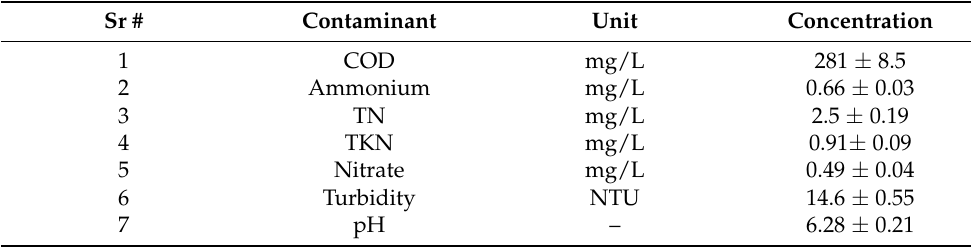
Table 1. Properties of influent wastewater.